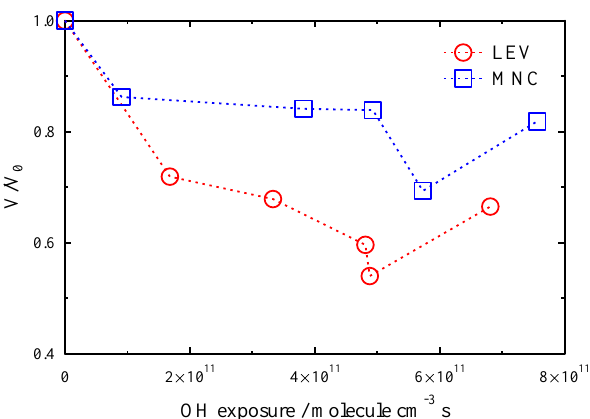
Figure 6. Derived κ (top) and critical particle diameter (bottom) for LEV and MNC particles are shown as a function of OH exposure. As indicated in the legend, the colors represent the different super- saturations ( S ) accessed during this study. The vertical error bars represent ± 1 σ from the mean of the data acquired at a given OH exposure and S . Horizontal error bars correspond to the uncertainty in the OH exposure based on a ± 5% drift in RH over the sampling period. The dotted lines show the best linear fit to the OH exposure data as a function of S